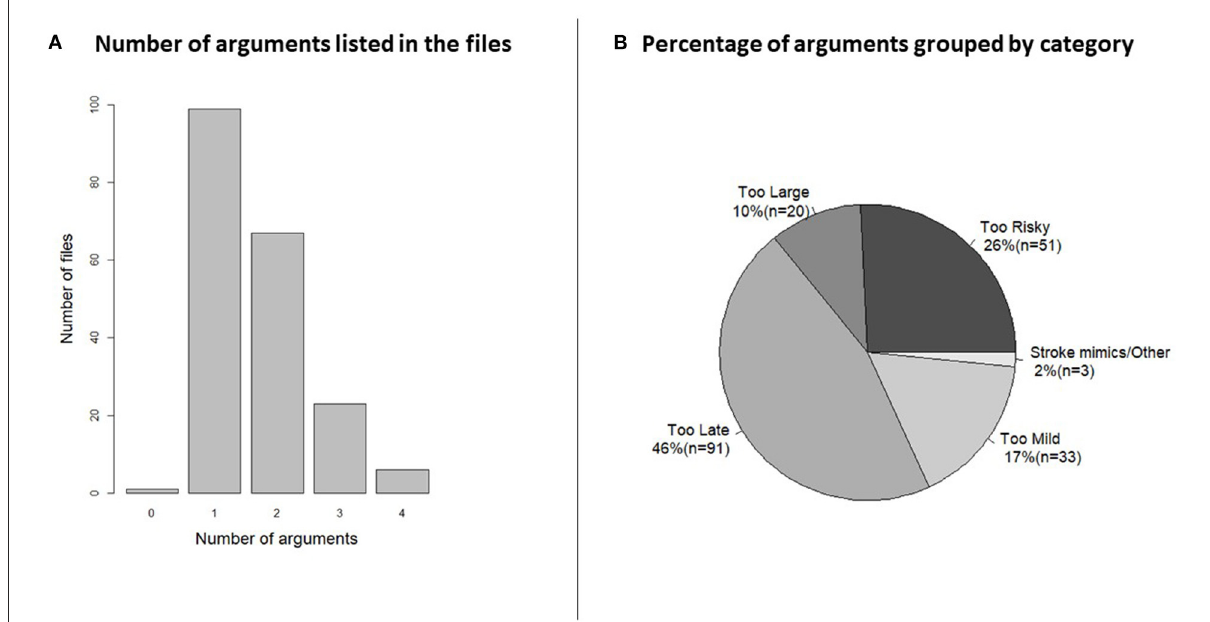
FIGURE3 (A) Histogram of the number of arguments shows how the half of the patient files had just one argument for not treating but the other half had more than one. Categorization of the arguments was necessary for visualization. (B) The pie chart shows the percentage and number (n) of patients in each category. AC, anticoagulants; DOAC, direct acting oral anticoagulants; PTT, partial thromboplastin time; INR, internationalized normalized ratio; ICH, intracranial hemorrhage; TIA, transitory ischemic attack; CVM, cerebrovascular malformation; LVO, large vessel occlusion; IVT, intravenous thrombolysis; EVT, endovascular treatment; CNS, central nervous